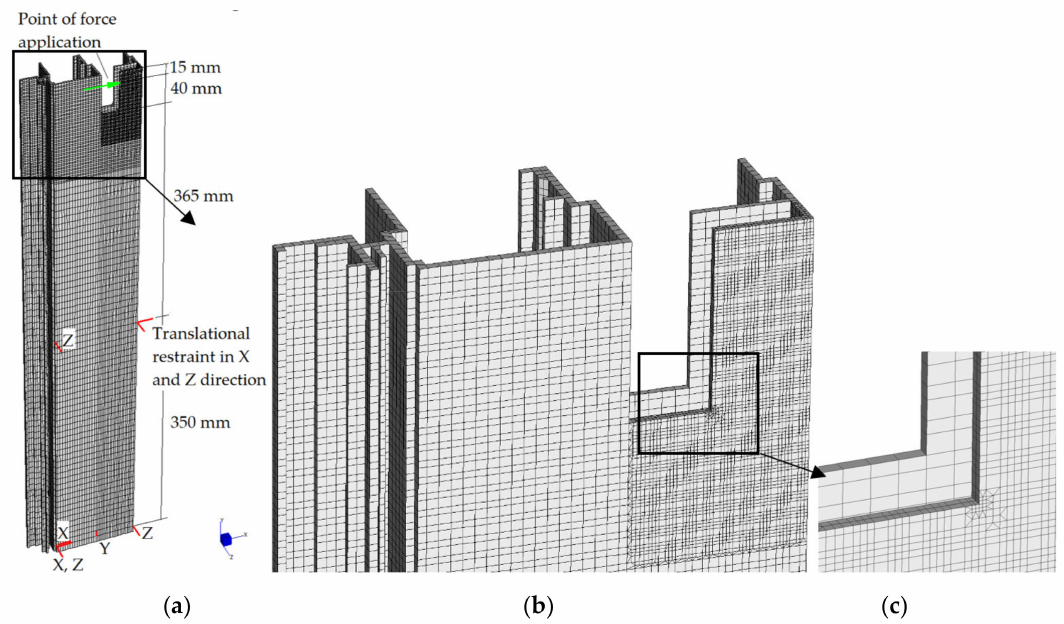
Figure 15. Element mesh: ( a ) entire model, ( b ) upper part, and ( c ) mesh around the root of the